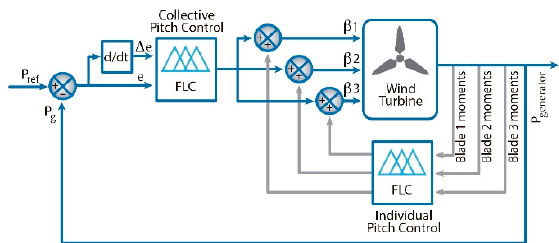
Figure 12. Control model that involves a combination of individual pitch control for each blade, this reduces the aerodynamic loads in the structure so it offers higher performance, and a collective pitch control to control the rotation of the turbine [61].